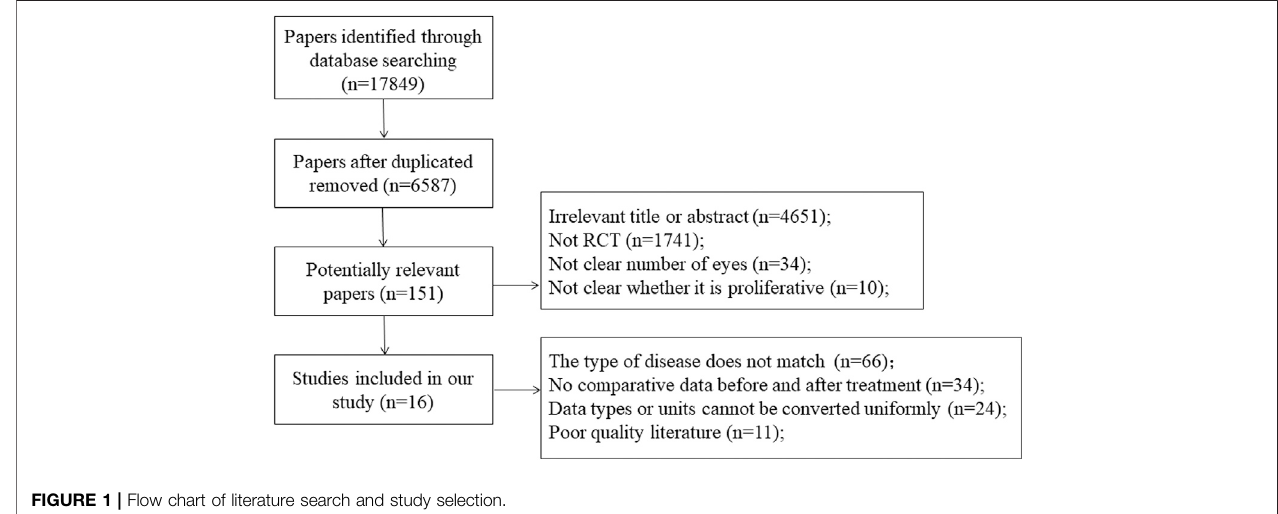
FIGURE 1 | Flow chart of literature search and study selection.